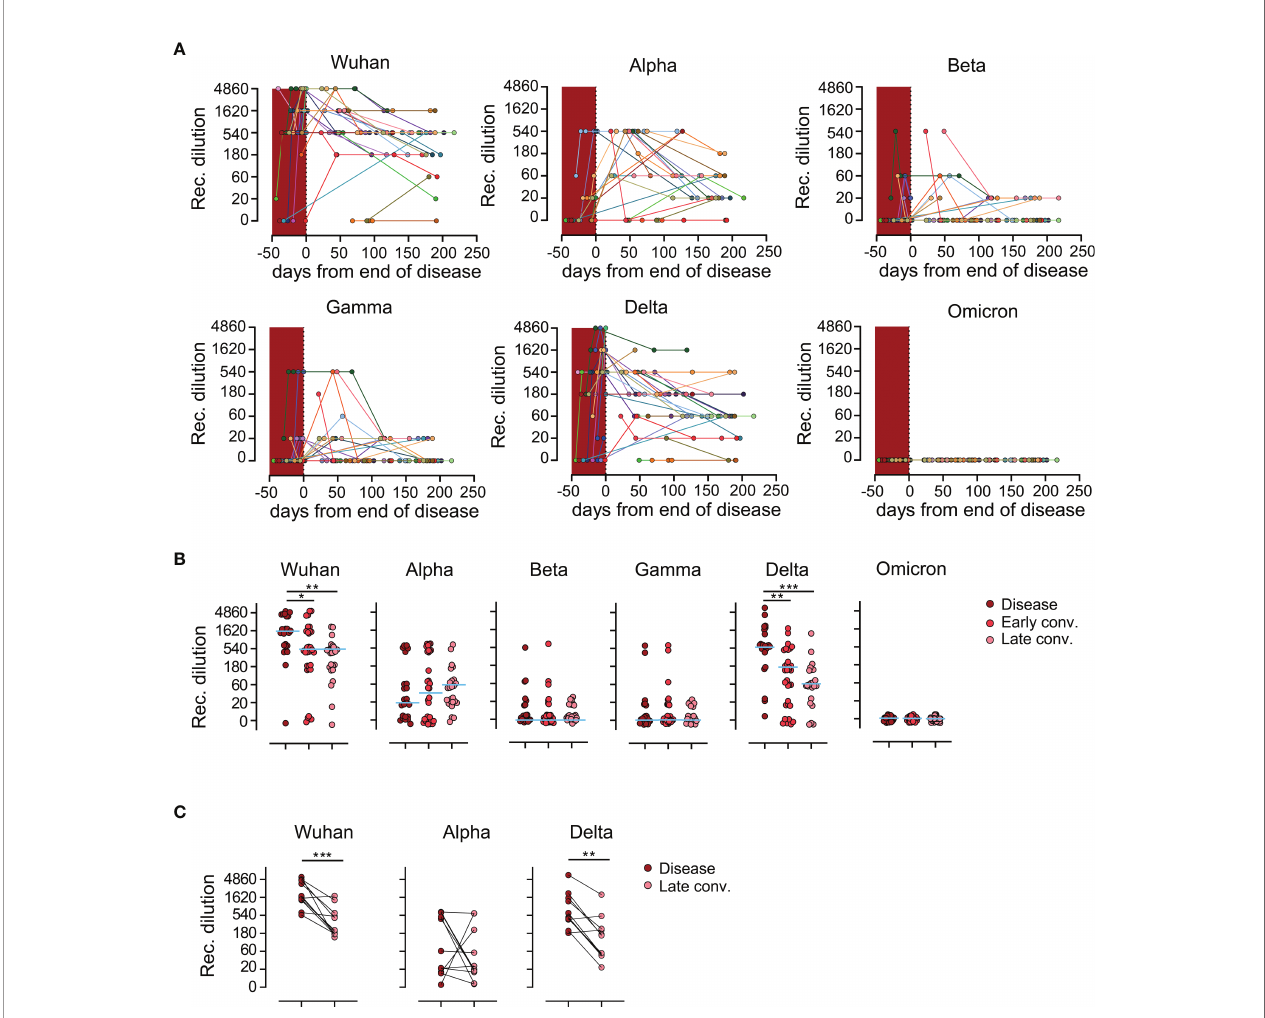
FIGURE 4 | Waning of humoral protection against Wuhan strain and variants of concern. (A) Reciprocal titers of neutralizing antibodies against Wuhan strain, Alpha (B.1.1.7), Beta (B.1.351), Gamma (B.1.1.28.1), Delta (B.1.617.2) and Omicron (B.1.1.529) SARS-CoV-2-S variants over time, measured using the sVNT. Each individually colored dot and connecting line represent one patient ( n =39 patients). Crimson shaded area represents time during the disease. (B) Reciprocal dilution titers of antibodies against Wuhan strain, Alpha, Beta, Gamma, Delta and Omicron variants. Each dot represents one biologically individual sample taken from one patient. N (disease)=23; n (early conv.)=32; n (late conv.)=25. (C) Longitudinal analysis of neutralizing antibodies titers in patients 3-7 months after the disease. Each connected dot represent one individual patient ( n =11). (B, C) for better visualization of identical titer values, data were randomly and proportionally adjusted closely around the precise titer results. Statistics: (B) Kruskal-Wallis multiple comparison test with Dunn ’ s post hoc correction. (C) Two-tailed Wilcoxon matched-pairs signed rank test. *p<0.05; **p<0.01;